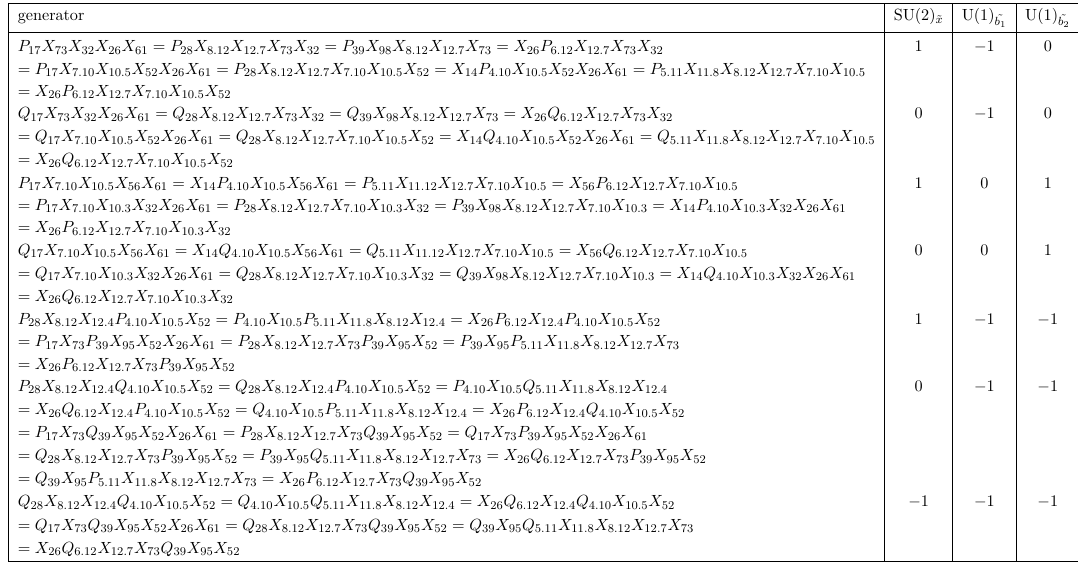
Table 73 . The generators in terms of bifundamental chiral fields for Model 18 (Part 1)